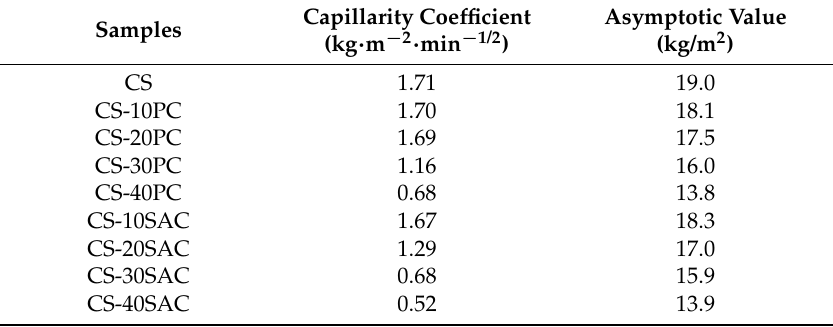
Table 4. Capillarity coefficient and asymptotic value of mortars at 28